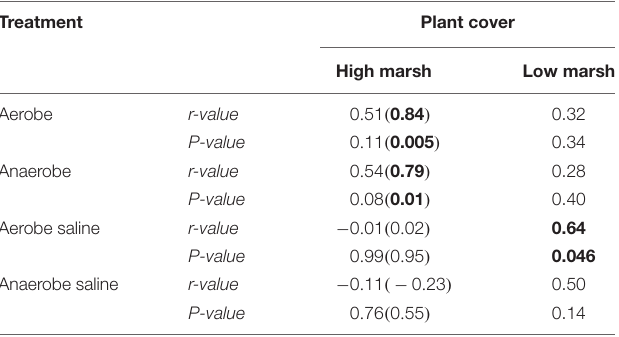
TABLE 4 | Summary of the Pearson product-moment correlation tests showing the correlation coefficient between the mean FW relative growth rate (g g − 1 d − 1 ) per treatment of the glasshouse experiments and the plant cover on the high and low marsh in the field ( n = 11 and n = 10 for the non-saline and saline correlations, respectively).